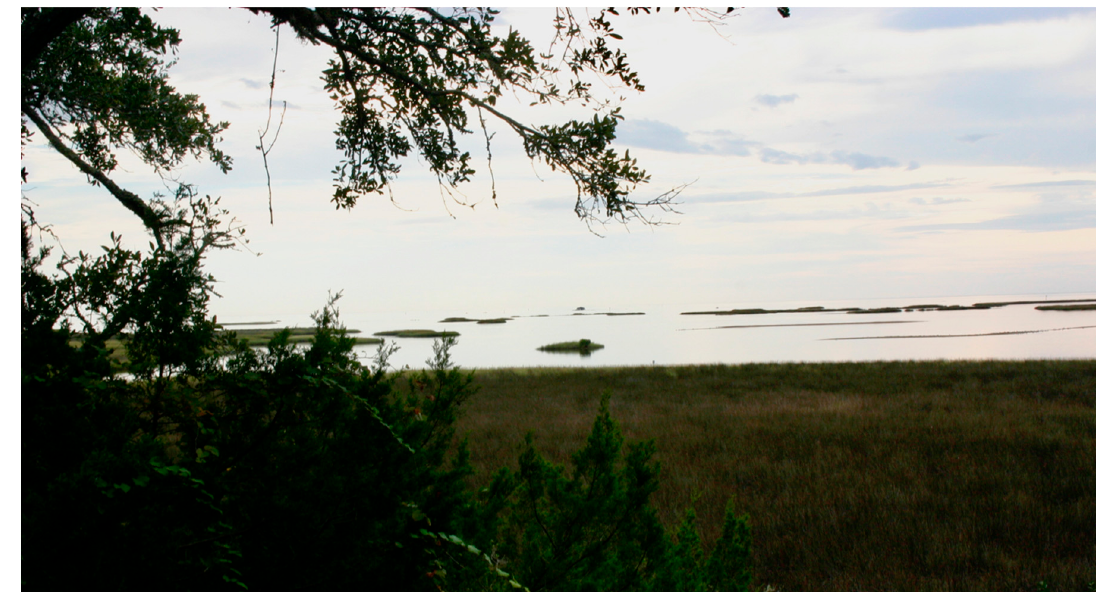
Figure 9. The view from Shell Mound. Photograph courtesy of the author.